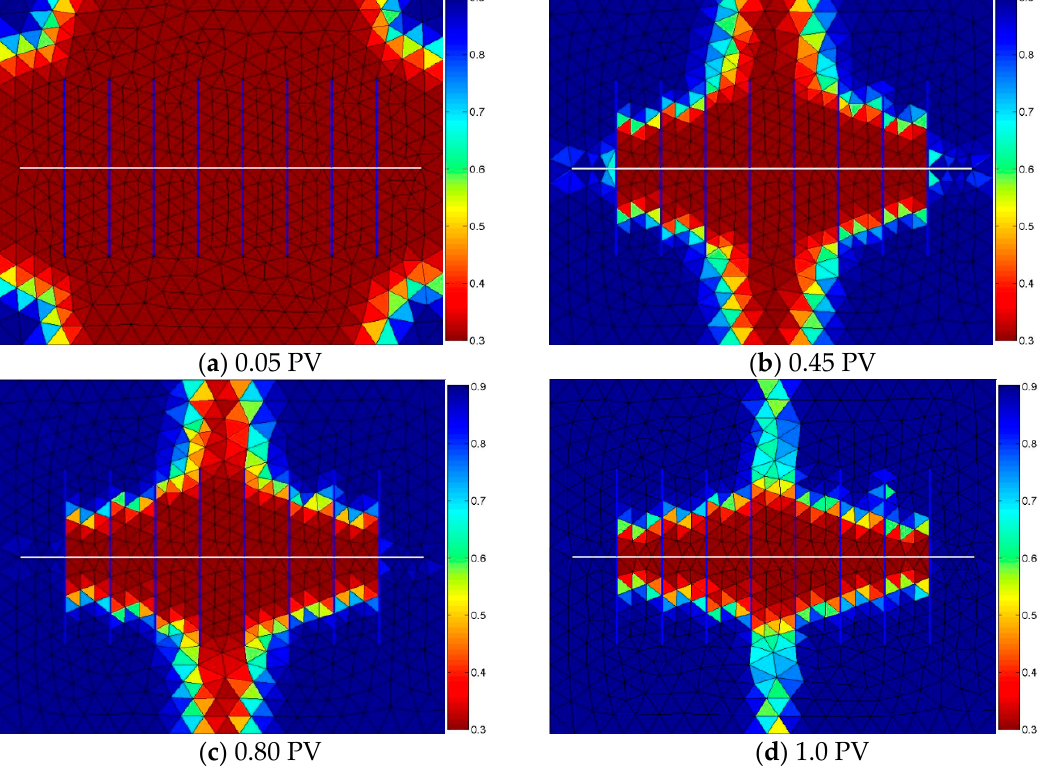
12 of 21 Figure 7. Evolution of frictional pressure drop across the horizontal wellbore.